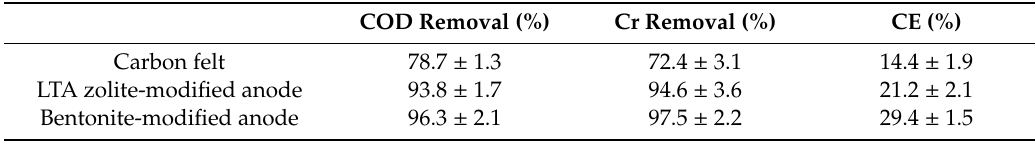
Table 1. COD removal rate and COD removal rate constant, chromium removal rate, and coulombic e ffi ciency (CE) obtained with unmodified and modified carbon felt bioanodes. COD Removal